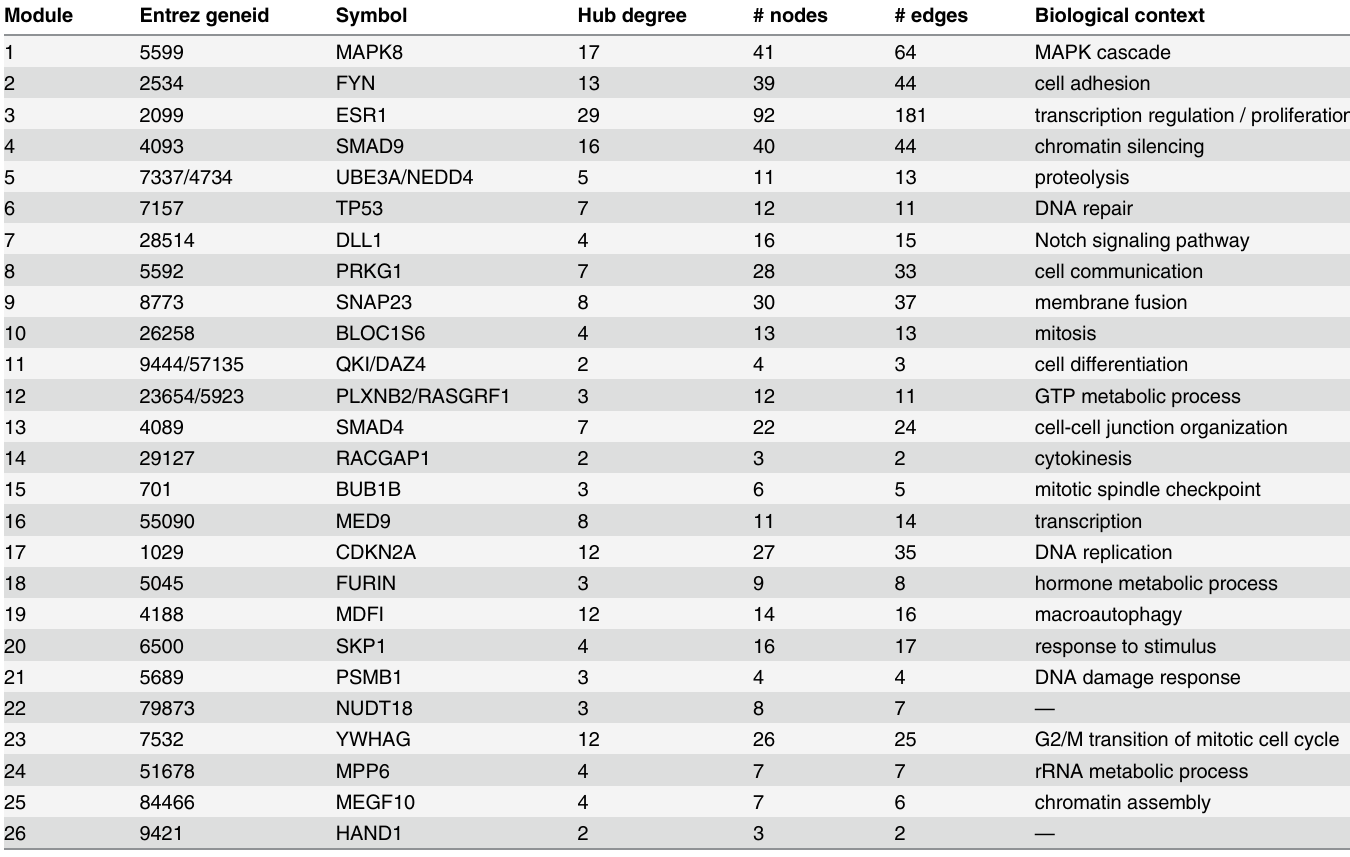
Table 4. Osteosarcoma network modules.